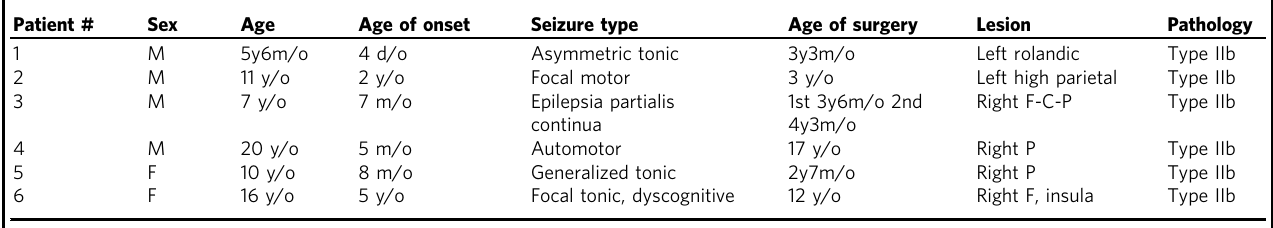
Table 2 Clinical data of FCD of